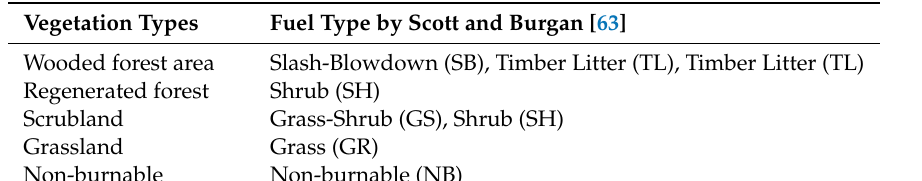
Table 2. Correspondence between vegetation type (basic fuel models) and Scott and Burgan’s models [63].